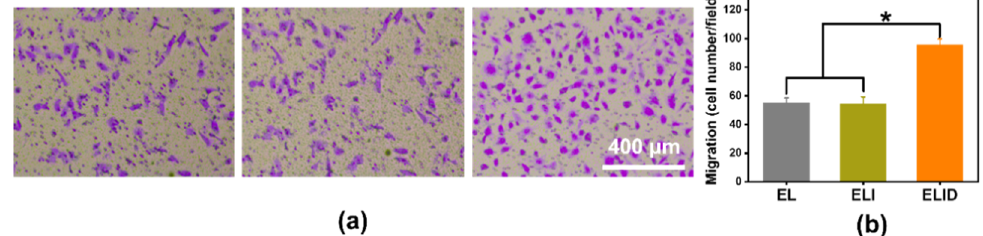
Figure 6. ( a ) HUVECs transwell assay of EL, ELI, and ELID (the scale bar = 400 μ m); ( b ) HUVECs migration number of fields for EL, ELI, and ELID (PBS as blank and n = 4, * indicates p ≤ 0.05).